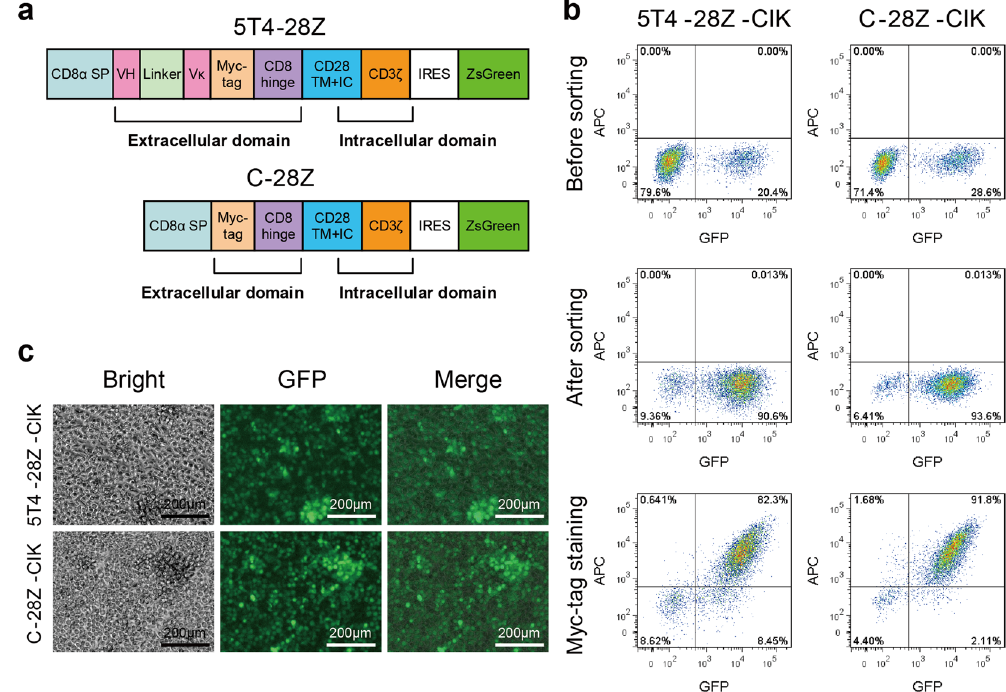
Figure 4. Generation and identification of CAR gene-modified CIK cells. ( a ) Schematic representation of the anti-h5T4 CAR construct and the control CAR construct. The 5T4-28Z CAR contained, in sequence from the N-terminus to the C-terminus, a CD8 α signal peptide (SP), an anti-h5T4 scFv comprising the variable regions of the heavy chain (VH) and light chain (V κ ) fused with a linker, a myc-tag sequence, a CD8 α hinge, the CD28 transmembrane (TM) and intracellular (IC) regions followed by the CD3 ζ signalling domain. The control CAR comprised a sequence identical to 5T4-28Z except without the scFv region. ZsGreen was used as a reporter gene. ( b ) CIK cells were generated as mentioned in the Methods section. They were transduced with CAR- encoded lentivirus and sorted using FACS according to the GFP expression. The surface expression of CARs on CIK cells was verified using FACS with an Alexa Fluor ® 647-conjugated myc-tag antibody. As controls, matched isotype antibody staining was incorporated. Flow plots are representative of quintuplicate cultures. ( c ) Brightfield and fluorescence images of sorted 5T4-28Z CAR- or C-28Z CAR-expressing CIK cells were captured. Representative images and merged images are